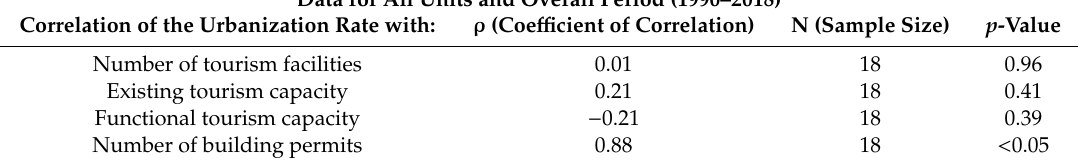
Figure 9. Dynamic of the number of tourism facilities on the Romanian seaside during 1990–2018. Source of data: Romanian Statistical Yearbooks (National Institute for Statistics).